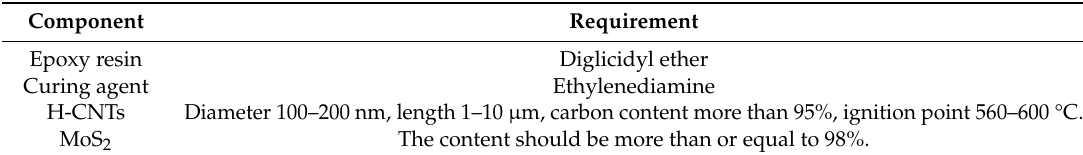
Table 1. Experimental materials.